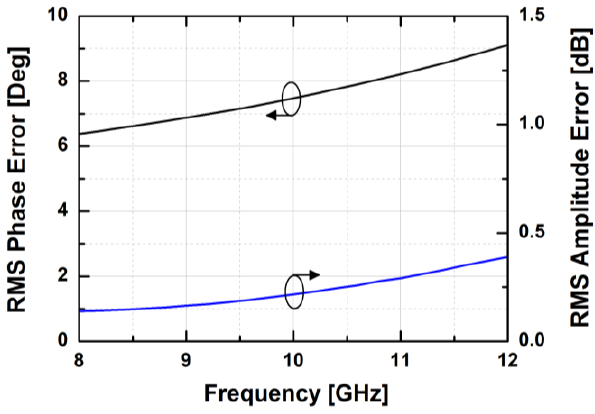
Figure 12. The RMS phase and amplitude errors in all of the attenuator’s attenuation states.